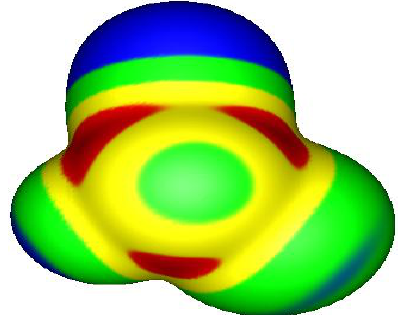
Figure 2. Electrostatic potential of chlorocyanofluorophosphine [PCl(CN)F], computed at the B3PW91/6-31G(d,p) level on the molecular surface defined by the 0.001 au contour of the electronic density. The phosphorus is in the middle, coming out of the page, the cyano group is toward the top, the chlorine to the right and the fluorine to the left. Color ranges, in volts, are: red, greater than 1.1; yellow, from 1.1 to 0.56; green, from 0.56 to 0; blue, less than zero (negative). There are three σ-holes on the phosphorus, along the extensions of the Cl–P, F–P and NC–P bonds; these are shown in red. Their most positive values are: Cl–P, 1.7 V; F–P, 1.5 V; NC–P, 1.4